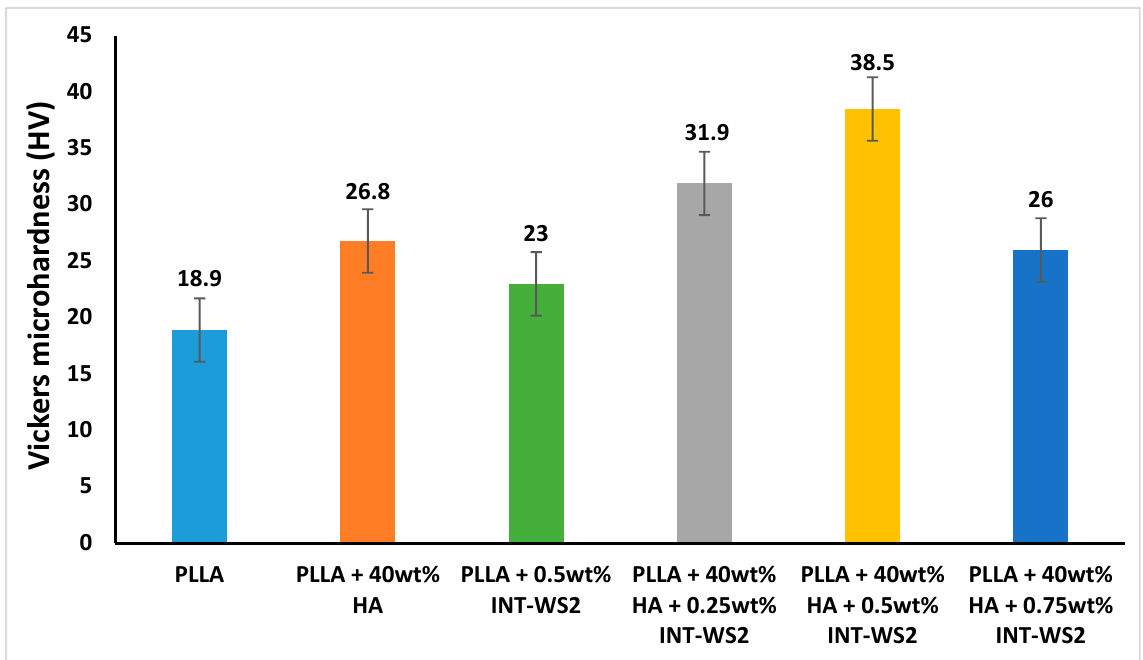
Figure 7. Vickers micro-hardness test of PLLA film and HA/INT-WS 2 /PLLA nanocomposites. The addition of HA nanoparticles to the PLLA film increased the hardness value (26.8